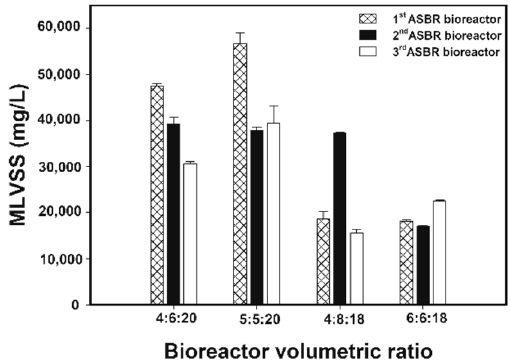
Figure 8. Effect of the bioreactor volumetric ratio on the MLVSS when the three-stage ASBR system was operated at a COD loading rate of 18 kg/m 3 d, 37 °C and 8 cycles / d .